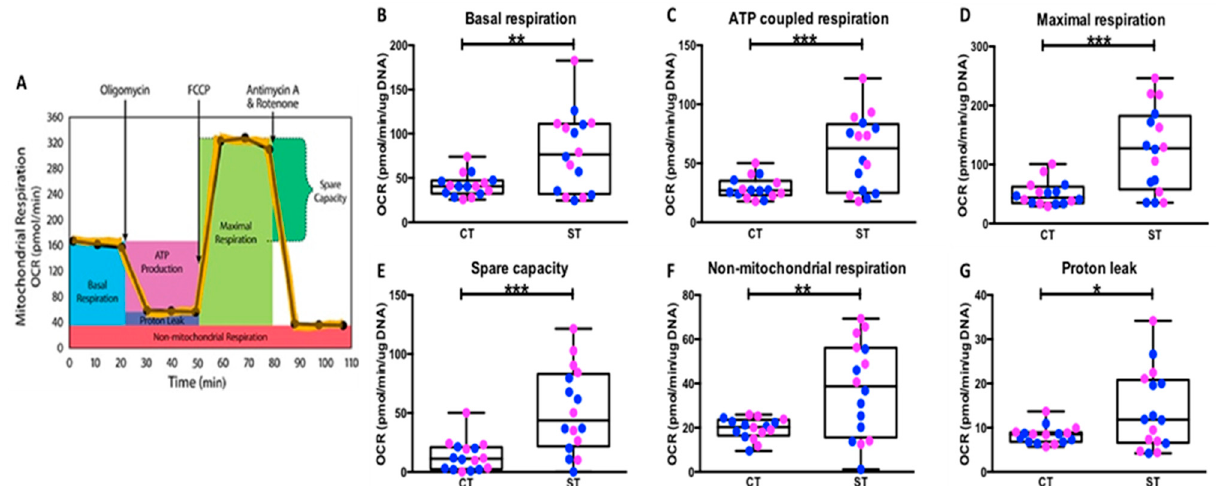
Figure 3. Mitochondrial respiration of CT vs. ST analyzed using the mitochondrial stress test. ( A ) Graphical representation of the mitochondrial stress test, ( B ) basal respiration, ( C ) ATP-coupled respiration, ( D ) maximal respiration, ( E ) spare capacity, ( F ) non-mitochondrial respiration, and ( G ) proton leak. Male (blue, n = 8) and female (pink, n = 8) groups combined. Data presented as minimum, maximum, median, 25th and 75th quartiles boxes, and whisker plots. * p < 0.05, ** p < 0.01, *** p < 0.001, and Wilcoxon signed-rank test. FCCP: Trifluoromethoxy carbonylcyanide phenylhydrazone.